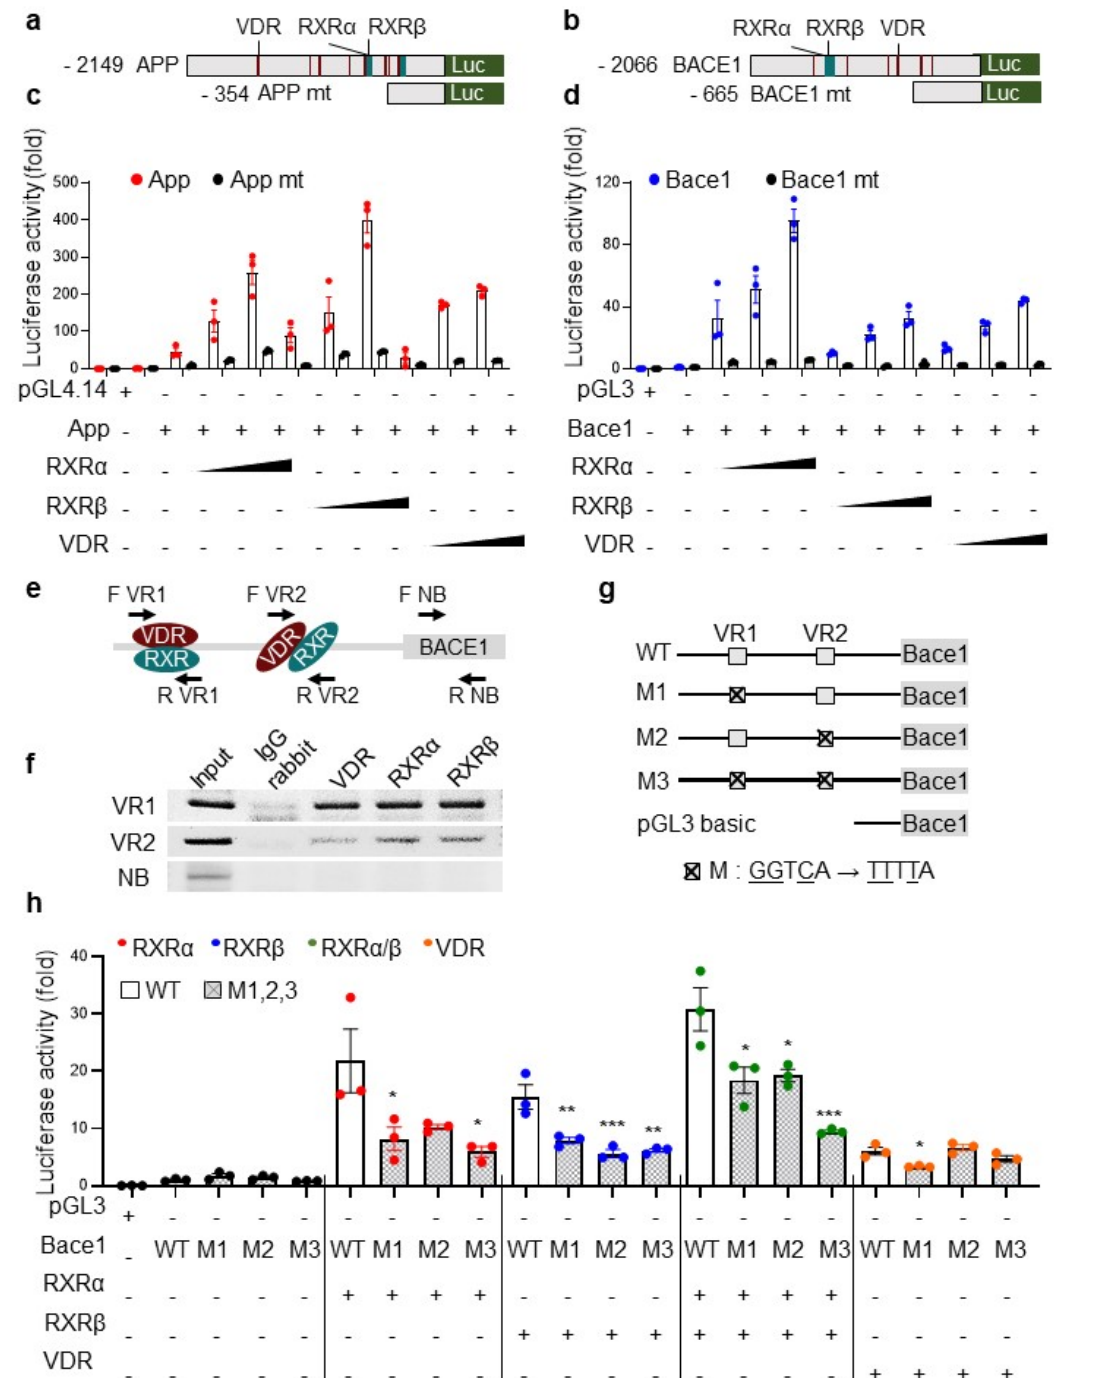
Figure 5. The transcriptional activation of app and bace1 is mediated by the direct promoter binding of RXR α / β and VDR: ( a , b ) Diagrams of app ( a ) and bace1 ( b ) mouse promoters containing RXR and VDR binding sites, or deleted RXR and VDR binding sites: app mt ( a ) or bace1 mt. ( b ) The transcriptional binding sites of RXR and VDR were predicted by the programs TRANSFAC and Vector NTI. ( c – d ) The effects of transcriptional activation of rxr α , rxr β , or vdr on various mouse truncated luciferase reporters of pGL4.14- app ( c ) or pGL3- bace1 . ( d ) RXR α , RXR β , or VDR was transiently coexpressed with various truncated pGL4.14- app or pGL3- bace1 luciferase reporters, and pRL-TK Renilla luciferase in HEK293T cells for 24 h. Data show the mean ratios for multiple experiments ( ± SEM). ( e ) A schematic diagram of RXR or VDR responsive element binding sites on the human bace1 promoter region with the detection primer sets for ChIP in Figure 5f: VR1 (VDR/RXR binding region 1), VR2 (VDR/RXR binding region 2), and NB (non-binding region). F and R denote the forward and reverse primer, respectively, and the detection primer regions are shown by arrows. ( f ) After chromatin from HEK293 cells was immuno-